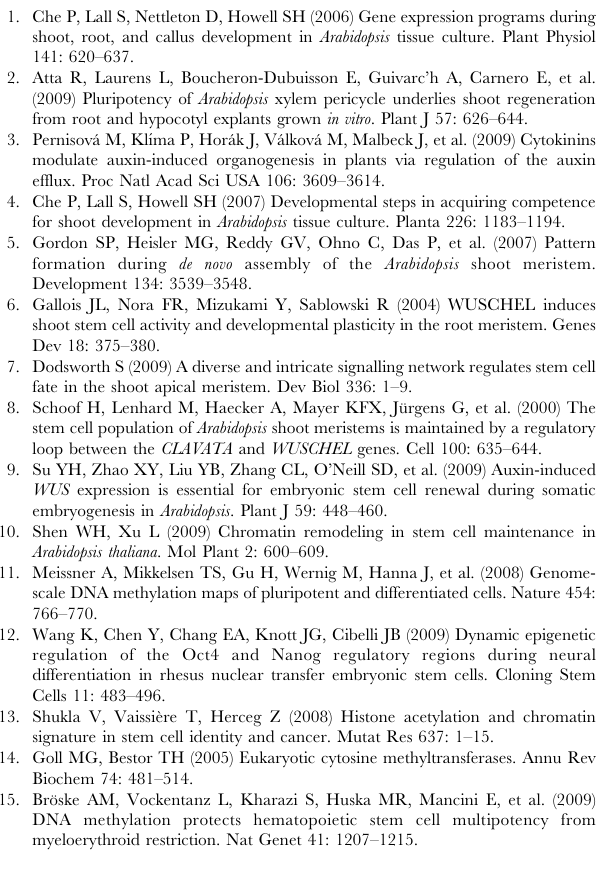
Table S2 The number of pWUS::GUS signal distribution detected in each callus. Table S3 List of 1334 up-regulated genes and 501 down- regulated genes in S6 as compared to S0. Table S4 List of 768 genes showing more than two-fold difference between M0 and S0. Table S5 List of 308 genes showing more than two fold difference both between S6 and S0 and between M0 and S0. Table S6 Sequences of primers used in this